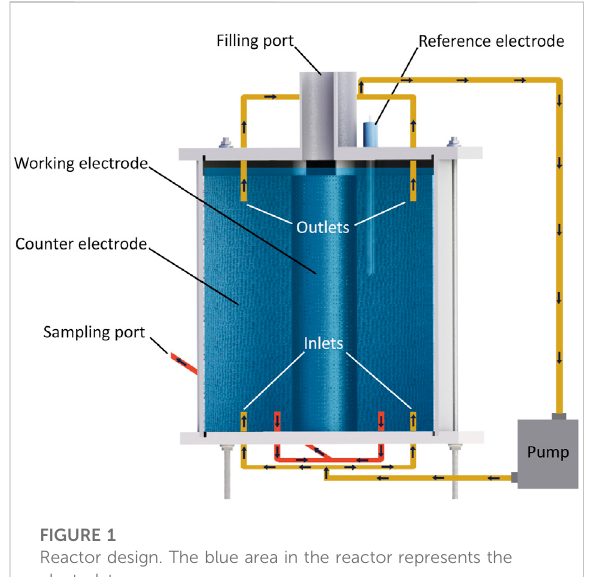
Reactor design. The blue area in the reactor represents the